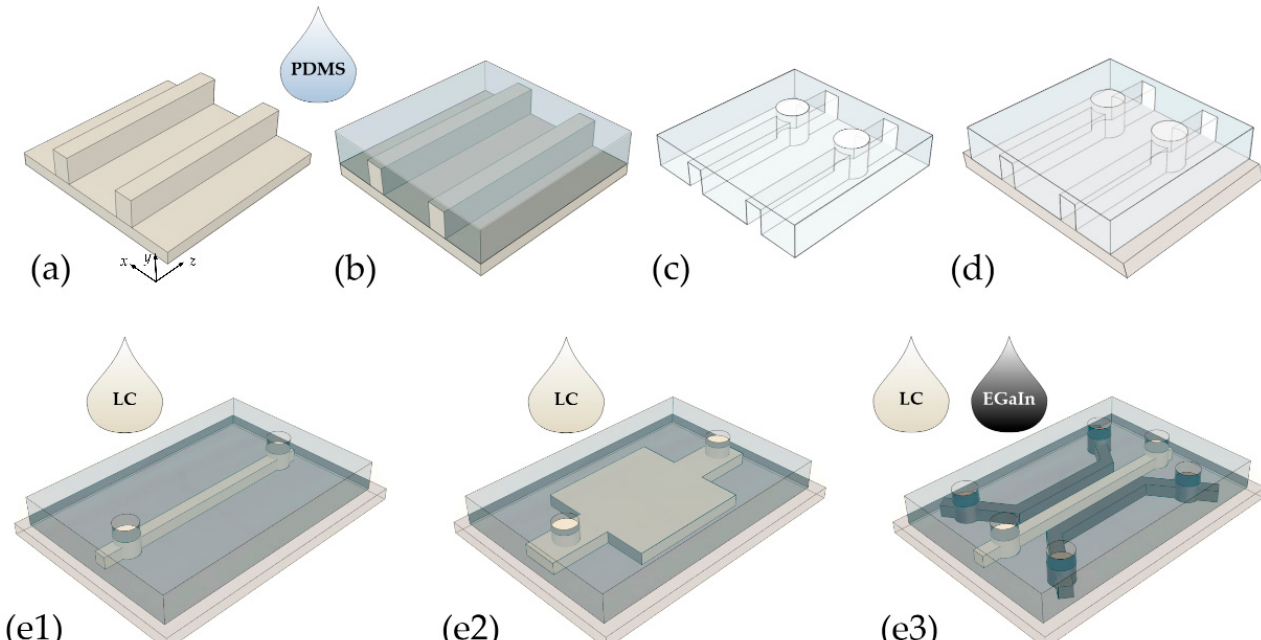
Figure 1. ( a – d ) Schematic illustration of the main steps of the PDMS microchannel fabrication based on the cast-molding technique. ( a ) Master mold with the desired surface pattern. ( b ) PDMS precursor poured into the mold. ( c ) Thermally cured PDMS peeled from the mold, with the vertical insets and outlets which were drilled. ( d ) Pattern PDMS attached to the substrate. Microchannels ready to be infiltrated with LC. ( e1 – e3 ) Exemplary samples analyzed in this